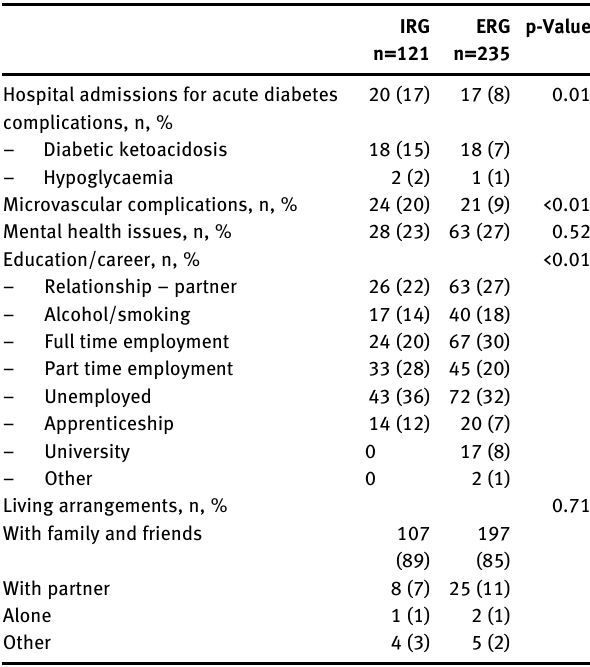
Table  : Diabetes complications, mental health and socioeconomic factors.